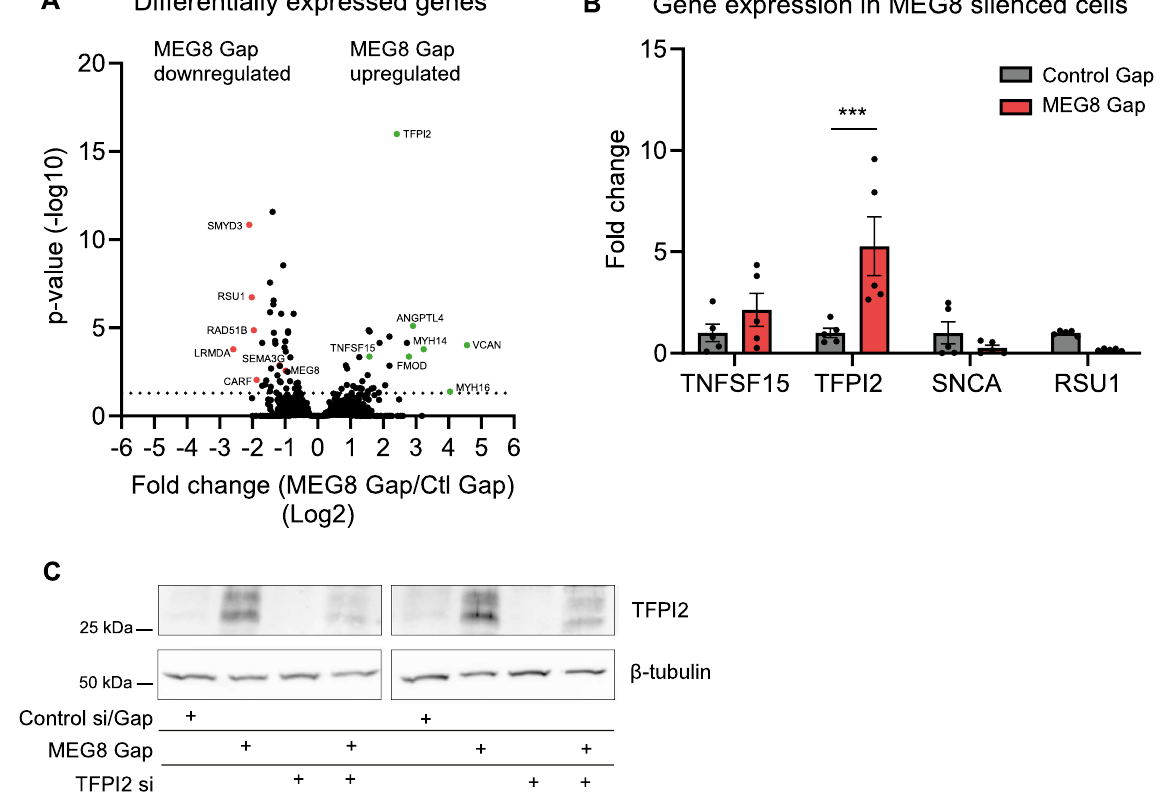
Figure 2. TFPI2 induction following loss of MEG8. ( A ) Changes in gene expression after GapmeR-mediated silencing of MEG8 were analysed by RNA sequencing. RNA was collected 48 h after transfection. ( B ) A subset of genes related to angiogenesis was validated by RT-qPCR. TFPI2 was significantly induced. Expression is relative to RPLP0. ( C ) TFPI2 protein levels were determined using Western blot. Cell lysates were collected 48 h after transfection. β-tubulin was used as a loading control. Images were cropped for clarity. Data is presented as mean ± SEM. Groups were analysed using one-way ANOVA. Significance was indicated as: * p < 0.05, ** p < 0.01, *** p <